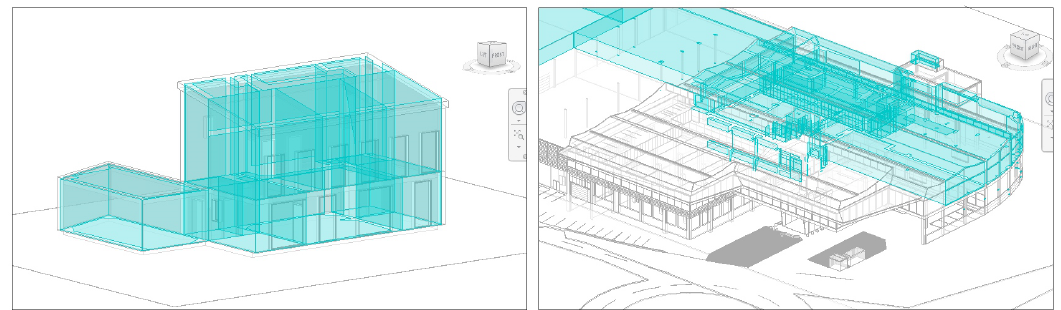
Figure 3. Analytical model of the residential and warehouse